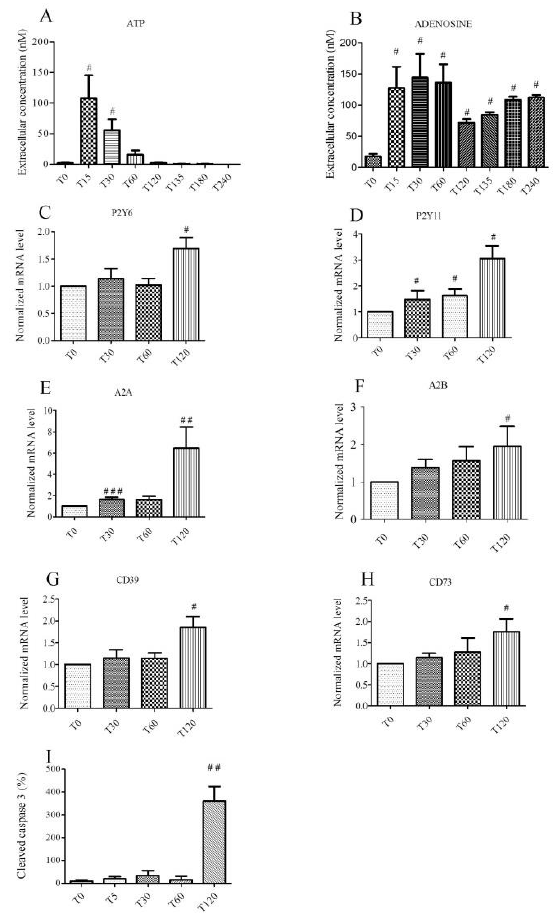
Figure 1. Effect of a 2-h hypoxia on endothelial cells. Extracellular ATP ( A ) and adenosine ( B ) concentrations are expressed in nM, during hypoxia (T0–T120) and at re-oxygenation (T135–T240). Overexpression of mRNA for P2Y6 ( C ) and P2Y11 ( D ) receptors, adenosine receptors A2A ( E ), A2B ( F ), and ectonucleotidases CD39 ( G ) and CD73 ( H ) expressed with normalized mRNA levels using the following formula: 2 − ∆∆ CT as a function of time. Relative expression of cleaved caspase 3 by immunoblotting during hypoxia ( I ). Results are expressed as means ± sem ( n = 6/group). #: p < 0.05, ##: p < 0.01, ###: p < 0.001 compared to T0 group.